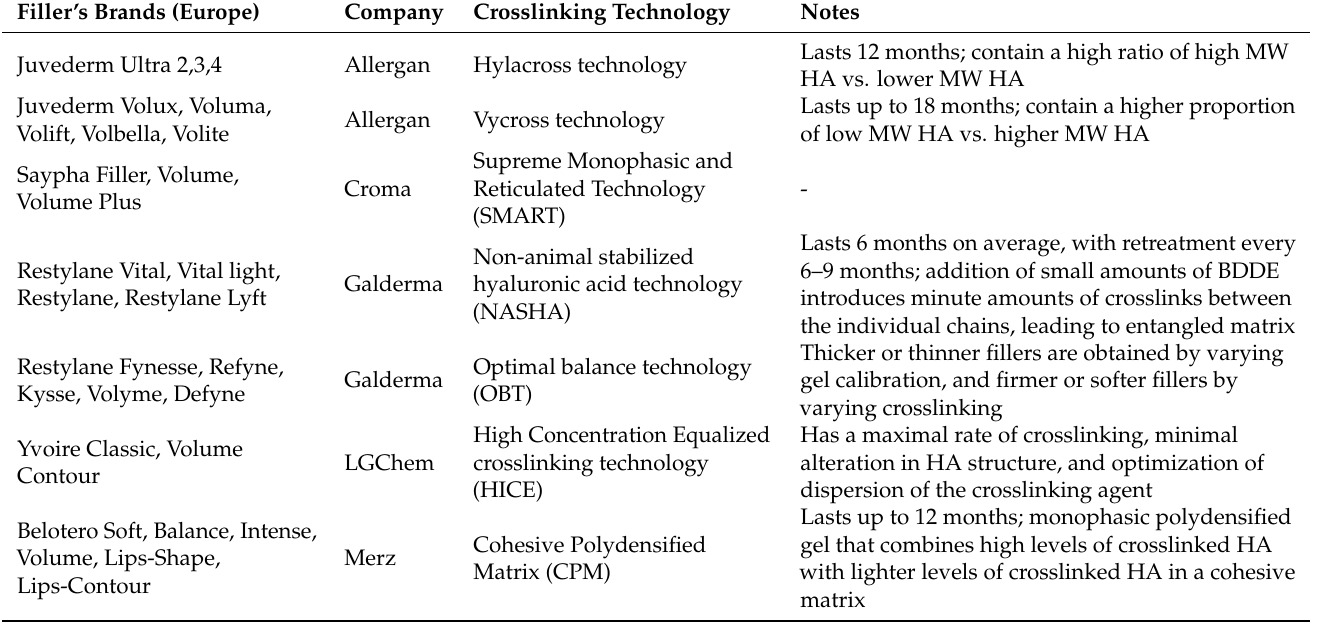
Table 2. Select filler brands, manufacturers, and crosslinking technology